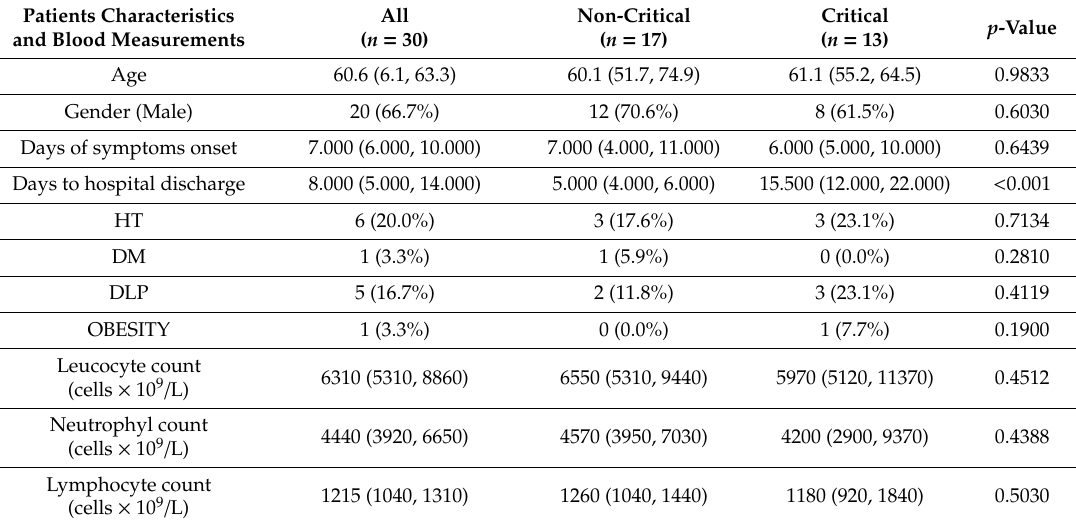
Table 1. Patients characteristics and blood measurements at time of admission and their univariate association with COVID-19